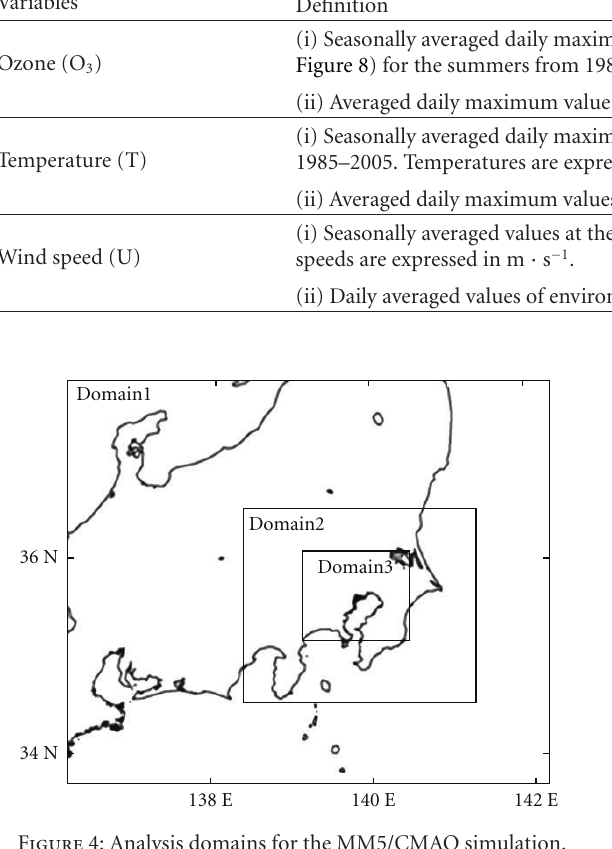
mapping, data format translation, units conversion, diag- nostic estimations of derived variables, and reconstruction of meteorological input on di ff erent horizontal and vertical grids through simple bilinear interpolation [34].